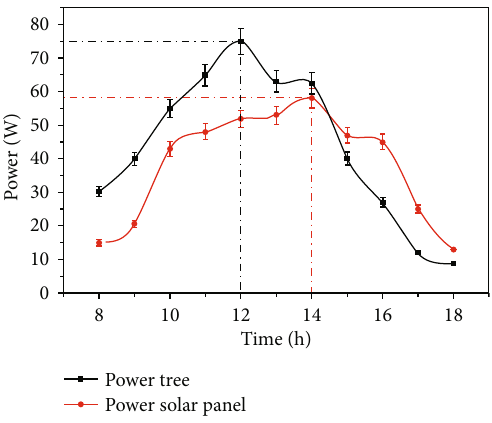
Figure 11: Variation in production power over